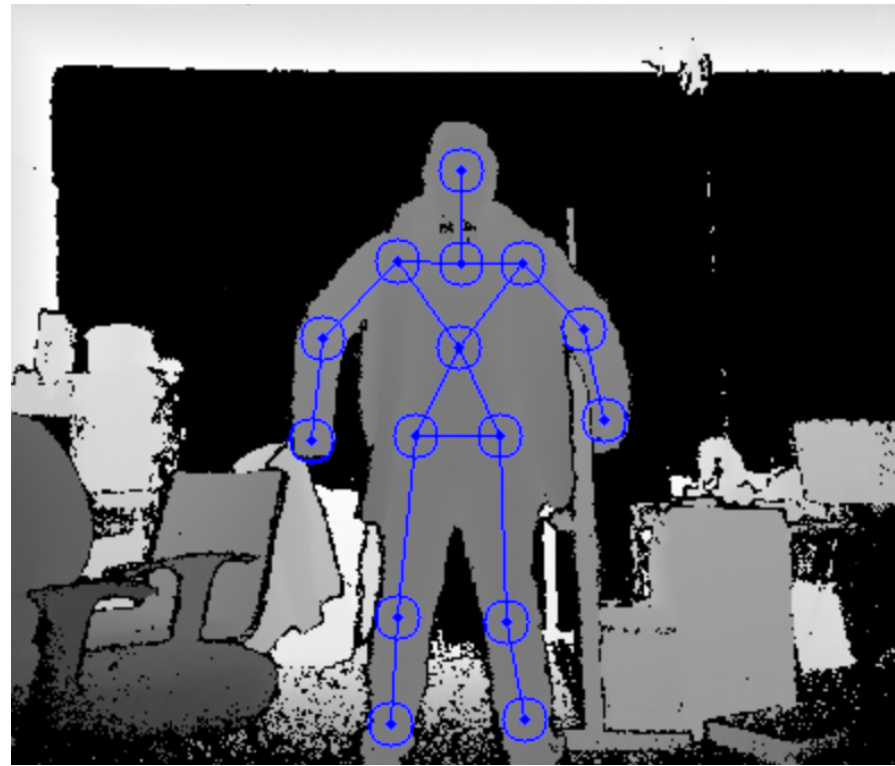
Figure 4. Skeleton tracking with the Kinect sensor and